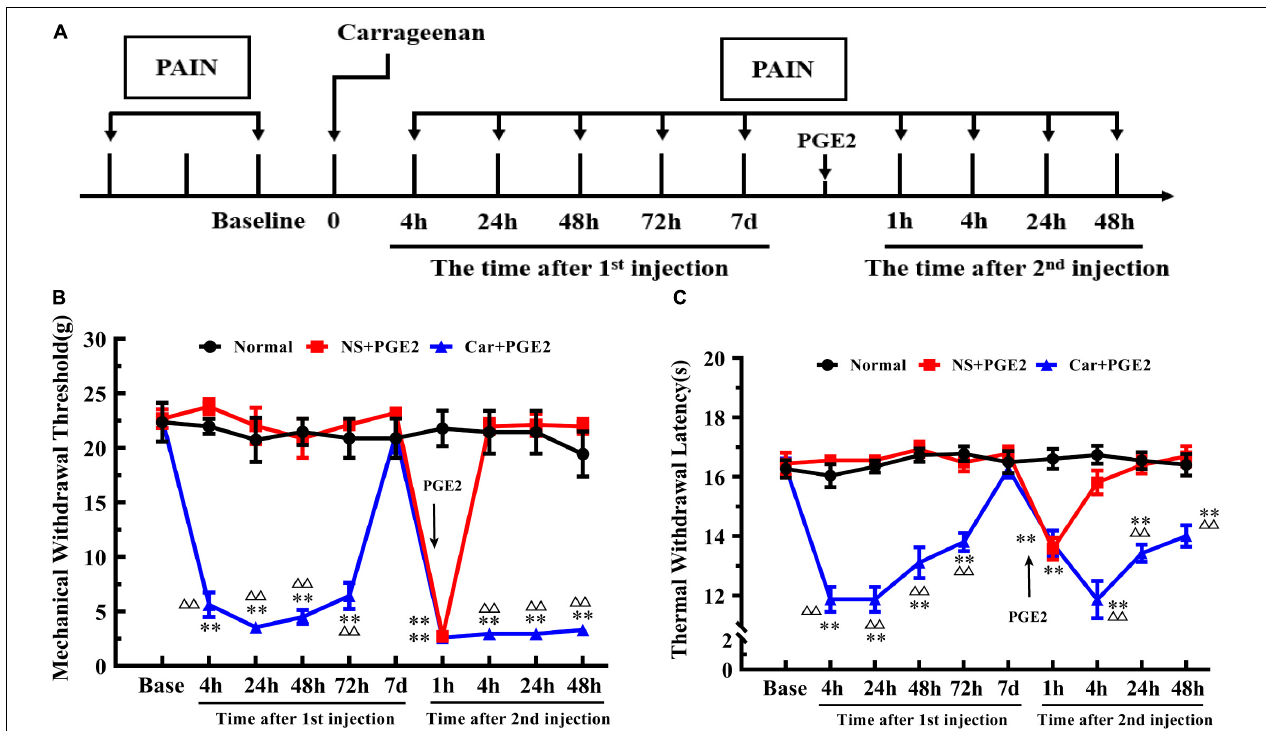
FIGURE 1 | Carrageenan injection followed by PGE2 injection produces chronic mechanical and thermal pain. The protocol of modeling (A) . The mechanical withdrawal threshold (MWT) (B) and thermal withdrawal latency (TWL) (C) of animals that received carrageenan and PGE2 injections. n = 6. **Compared with the normal group, P < 0.01; (cid:52)(cid:52) compared with the NS+PGE2 group, P <